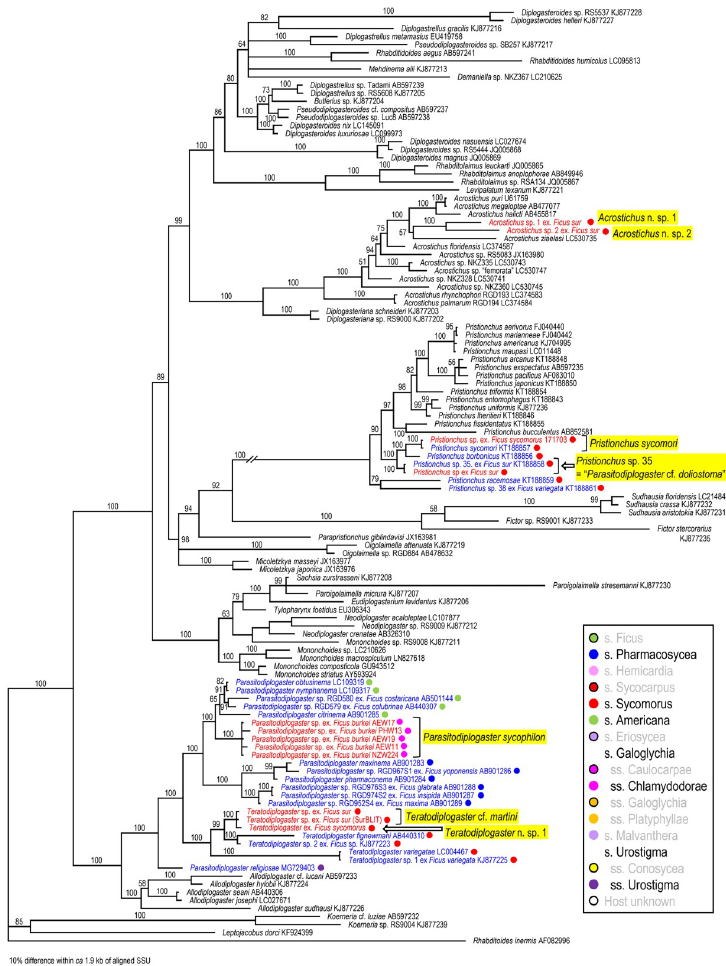
Fig 5. Phylogenetic status of fig-associated species within the family Diplogastridae inferred from SSU under GTR + G + I model. The parameters are: AIC = 50531.581, lnL = -25026.463, freqA = 0.25, freqC = 0.21, freqG = 0.27, freqT = 0.27, R(a) = 0.94, R(b) = 2.60, R(c) = 2.10, R(d) = 0.92, R(e) = 3.80, R(f) = 1.00, Pinva = 0.35, Shape = 0.53. Posterior probability values exceeding 50% are given on appropriate clades. Fig-associated nematode species obtained in the present study and previous studies are written in red and blue, respectively. Section or subsection of host fig species are coded with color